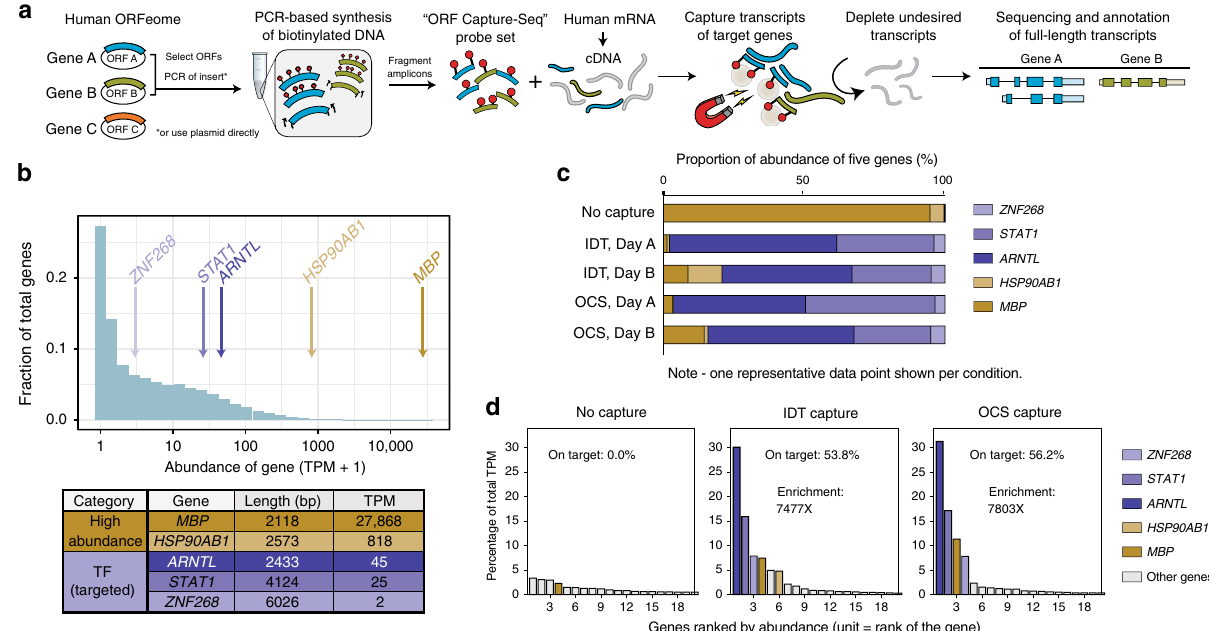
Fig. 1 ORF Capture-Seq (OCS) method for accelerated discovery of full-length isoforms. a Schematic of the OCS method. ORF clones of target genes are pooled and used as templates for a biotin-dUTP-labeling PCR reaction, creating randomly biotinylated amplicons which are fragmented to generate a probe set. In this study, PCR-based amplicons derived from the clones were used as template. These OCS probes can be used in targeted sequencing applications, such as enrichment of full-length cDNA for sequencing on the PacBio platform. b Transcriptional abundances in human brain cDNA. These values were used as the basis for selecting three low to moderate abundance transcription factors (TFs) as target genes (purple labels) and two high abundance genes (yellow labels) as background controls. Length is an average of all transcripts annotated for each gene (GENCODE v22). TPM values were obtained from processing Illumina sequencing data (Methods). TPM, transcripts per million. c Comparison of IDT vs OCS-based target enrichment. Each bar shows the relative proportion of cDNA from target (purple) versus background (yellow) genes as quanti fi ed by qPCR (average of two technical replicates). A total of three individual capture reactions were performed per day (see Supplementary Fig. 1e for full dataset) over two days (Day A, B). Only one of the three reactions is shown in this fi gure. d Individual gene expression, ranked in descending abundance, as quanti fi ed by Illumina sequencing and Kallisto (Methods). Each bar represents one gene. Only the 20 most abundant genes are shown. Bars are color coded as background controls (yellow), target genes (purple), and all remaining genes that were not targeted (gray). On-target percentages are the fraction of transcriptional abundance corresponding to the three targeted TFs ( ARNTL , STAT1 , ZNF268 ), in each capturant. Fold enrichment is computed by dividing percentage of targets in